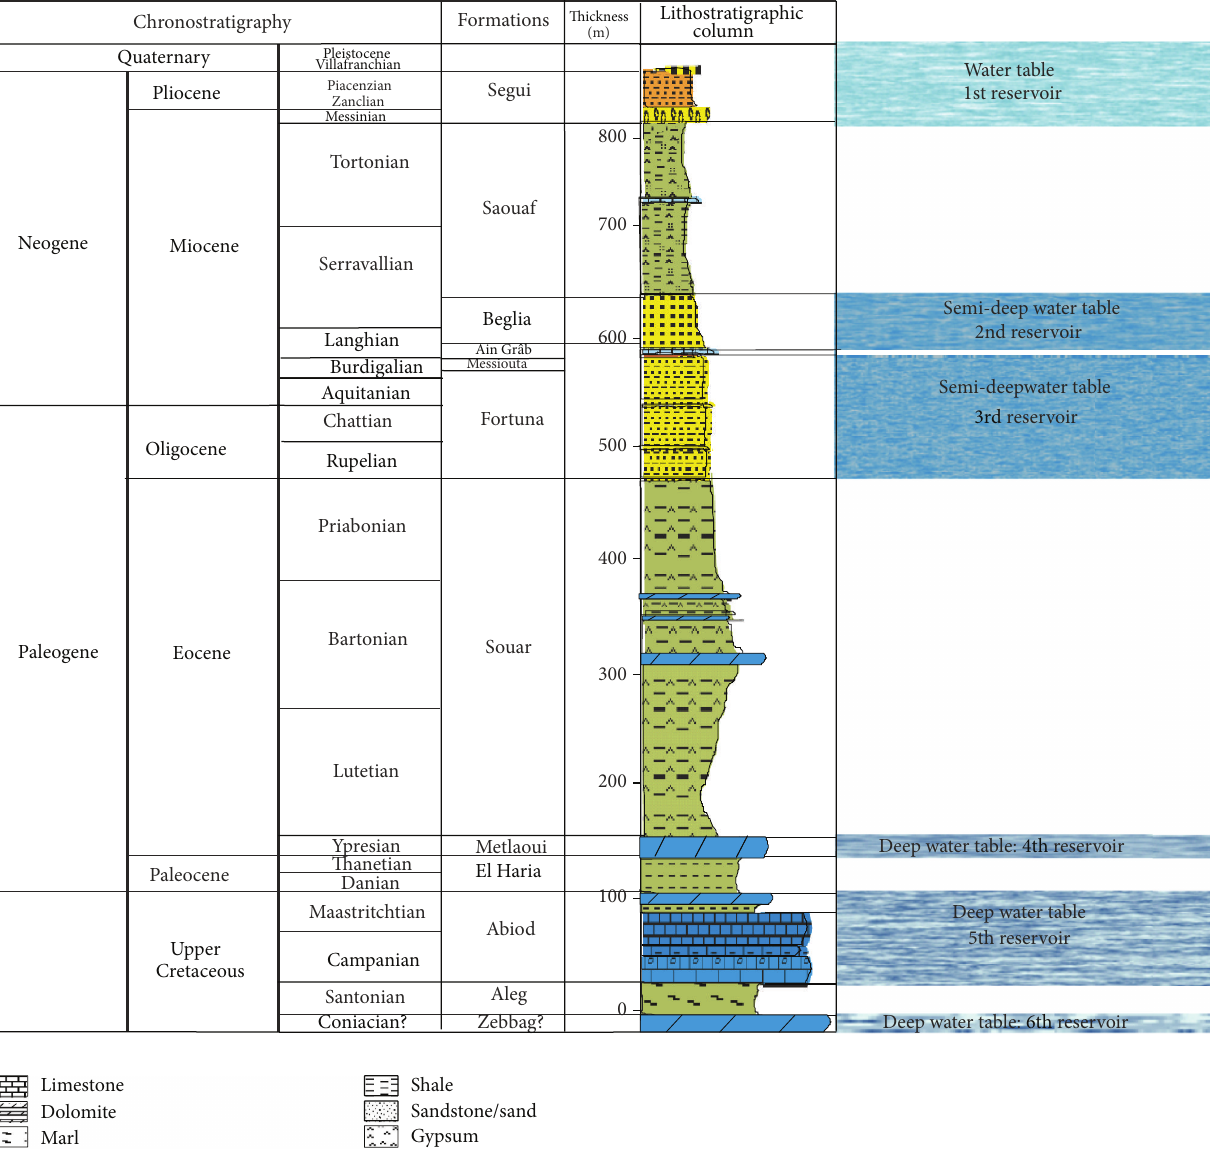
Figure 3: Lithostratigraphic column of Jebel Es Souda modified from